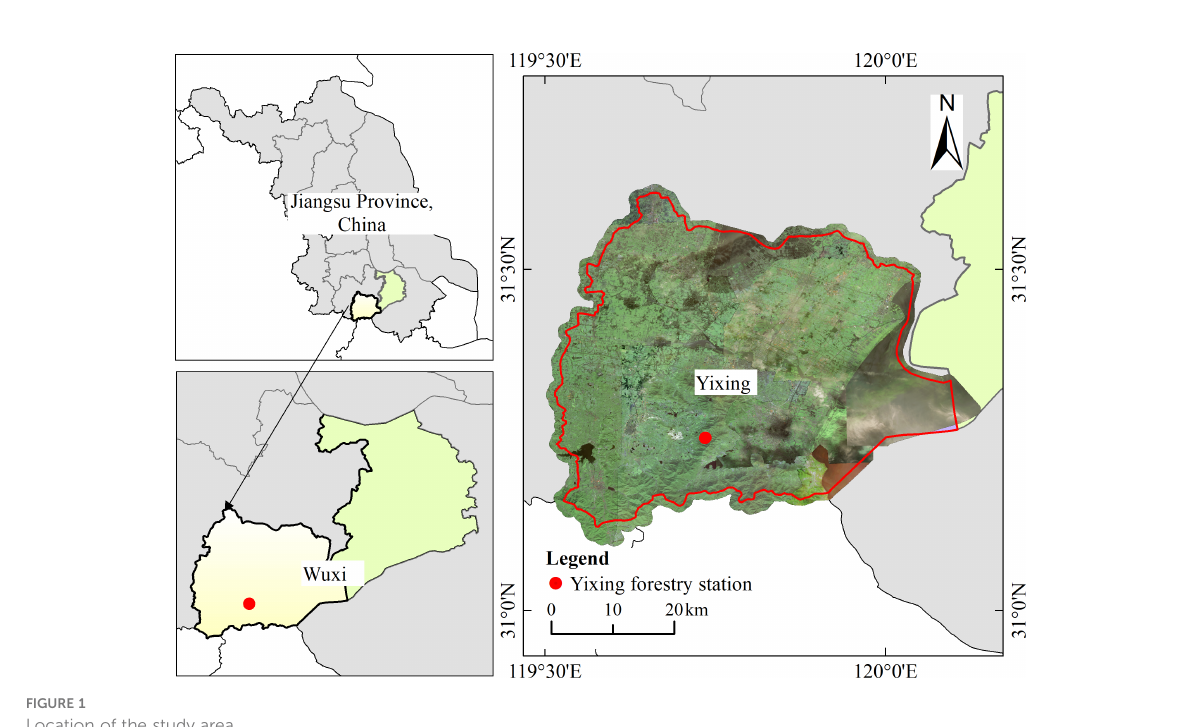
FIGURE 1 Location of the study